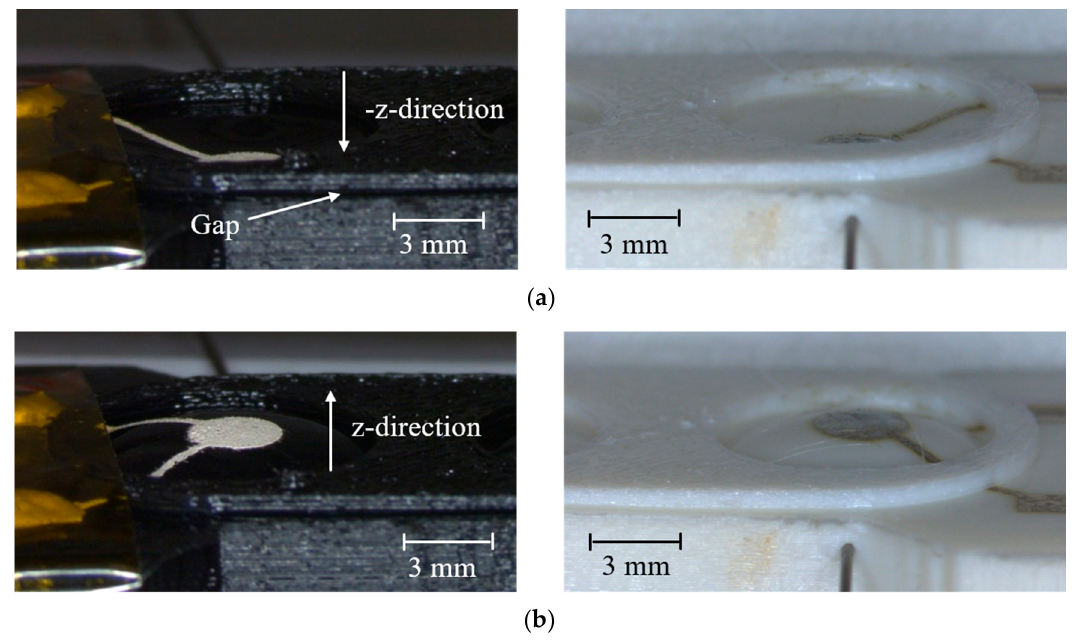
Figure 5. ( a ) View of the screen-printed ( left ) and inkjet-printed ( right ) electrodes with an applied pressure of ( a ) − 10 kPa and indrawn membrane (-z-direction); and ( b ) 75 kPa and dilated membrane.